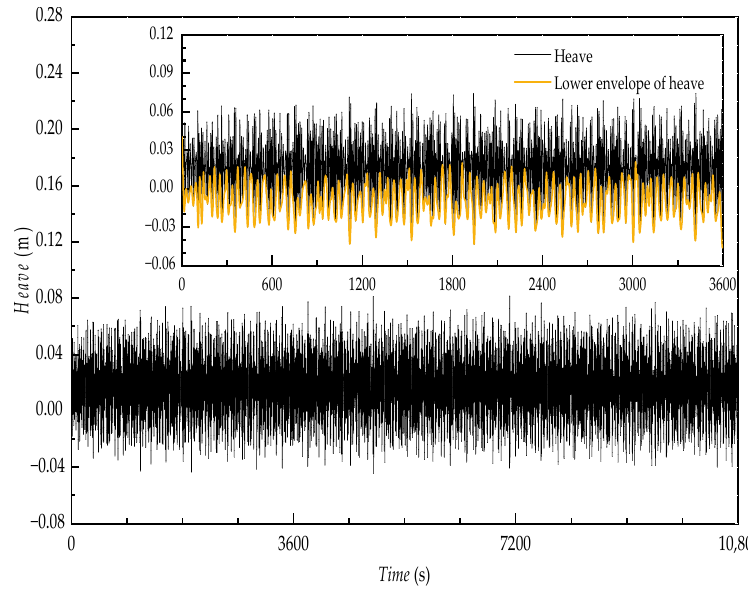
Figure 9. Heave in 3-h duration.